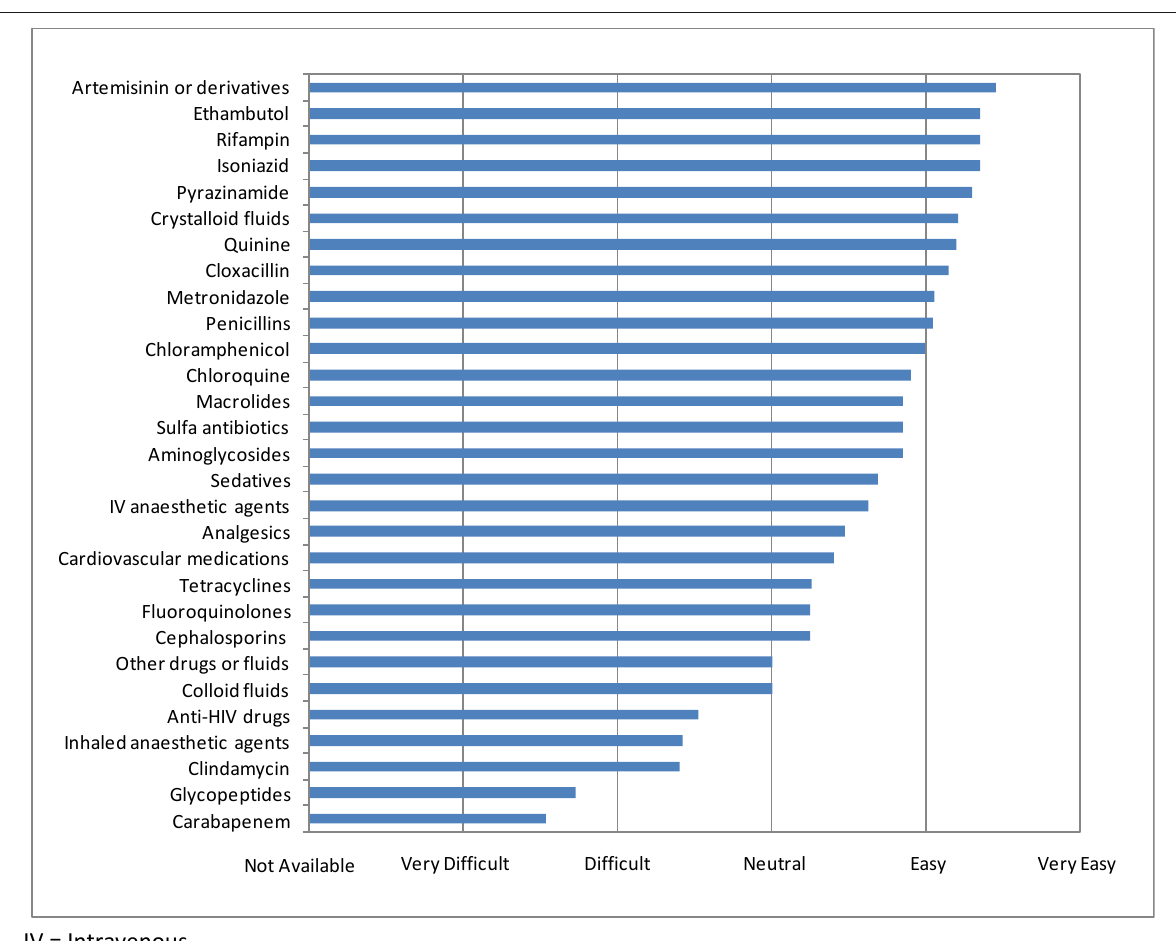
Figure 5 Ease of accessibility of medications .